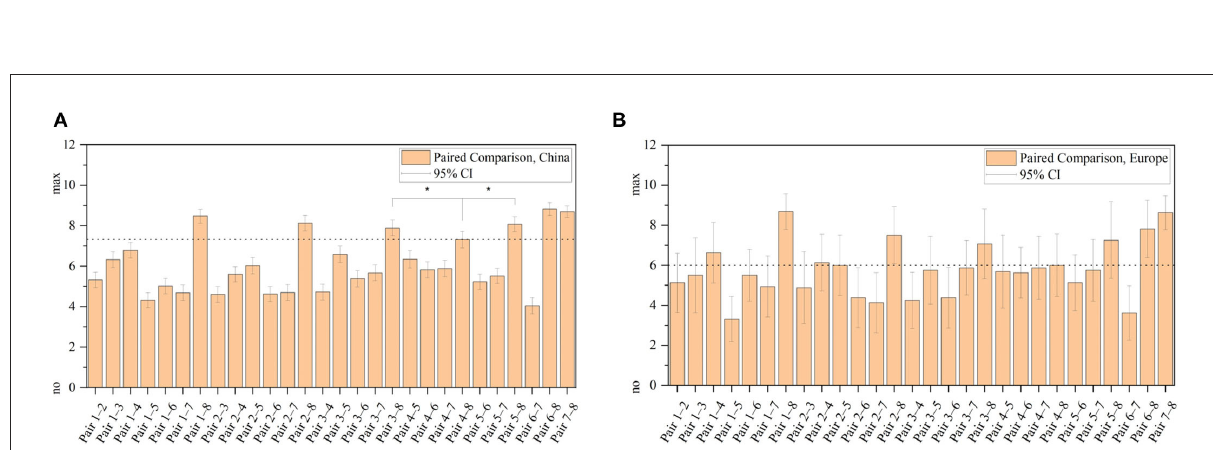
FIGURE3 Twenty-eight paired comparisons from China (A) and Europe (B) rated from 0 as no difference to 10 as maximum deviation. Paired numbers can be referred out of Table 2. Ninety-five percent confidence interval shows an error of one step size in the Chinese group. Significantly closest relation to L8 is L4, spatial cool white, marked with * ( p < 0.05) and as reference with a dashed